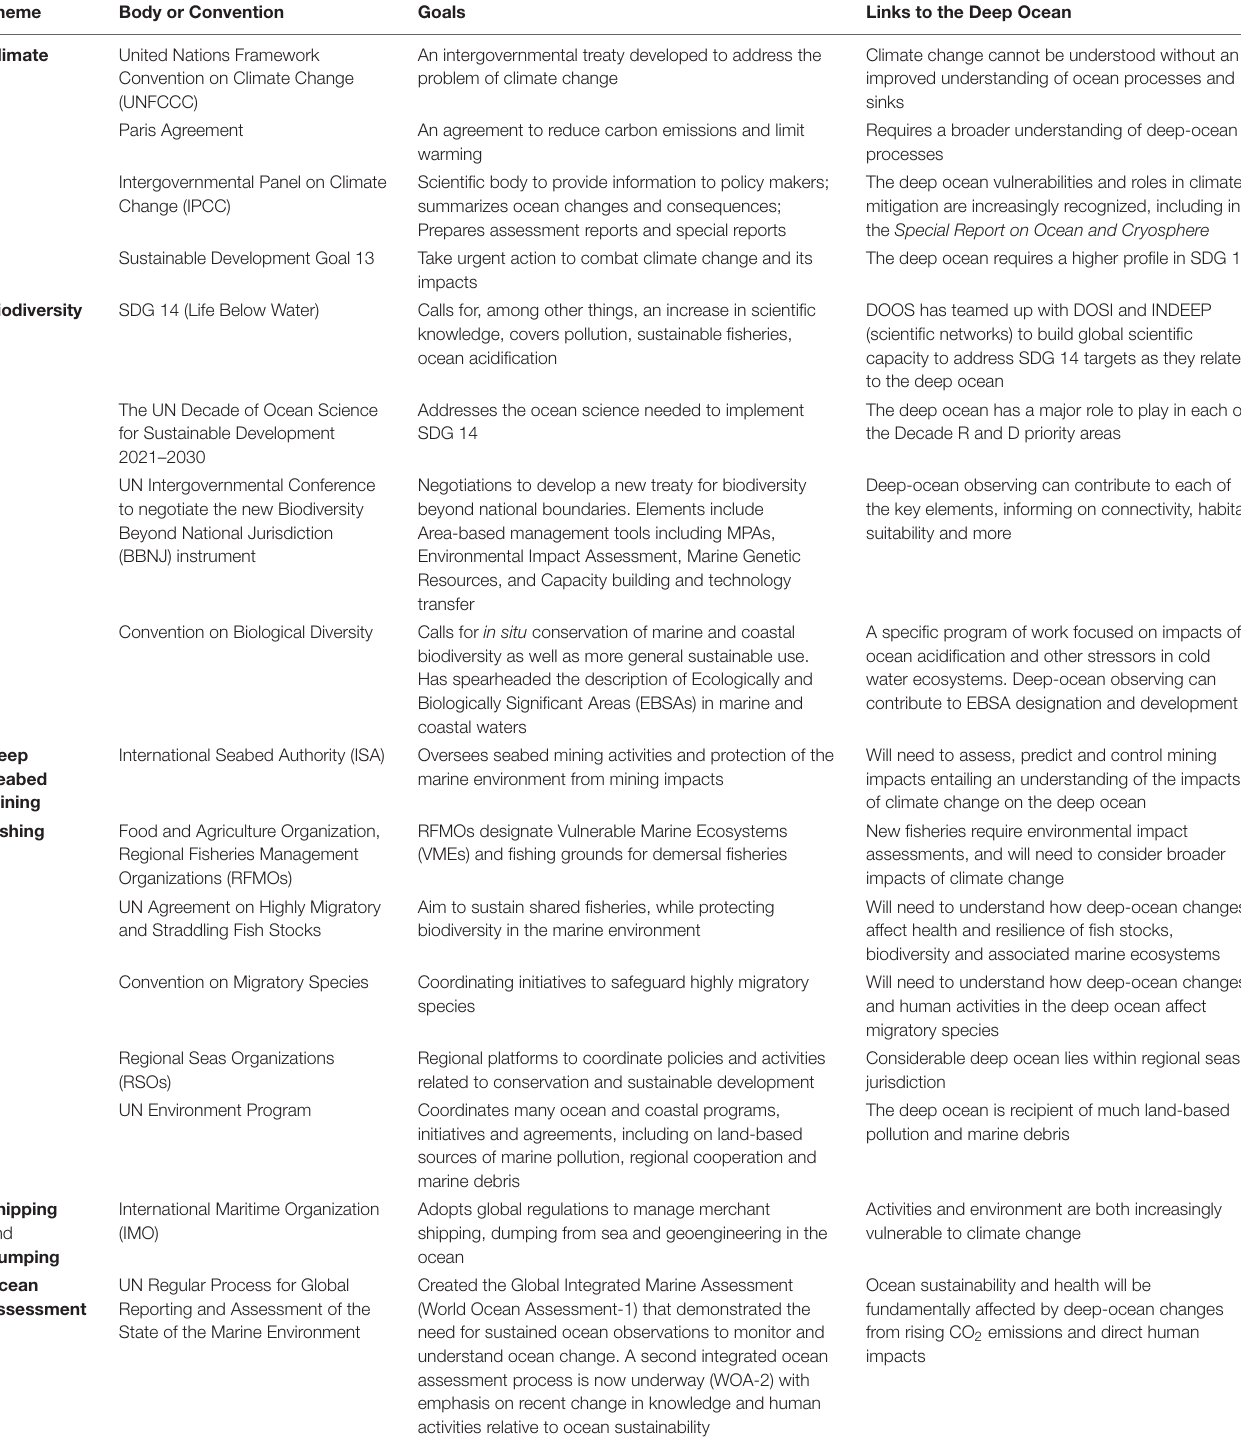
TABLE 1 | International policy-making bodies, initiatives and agreements that either require or would benefit from deep-ocean observations. Theme Body or